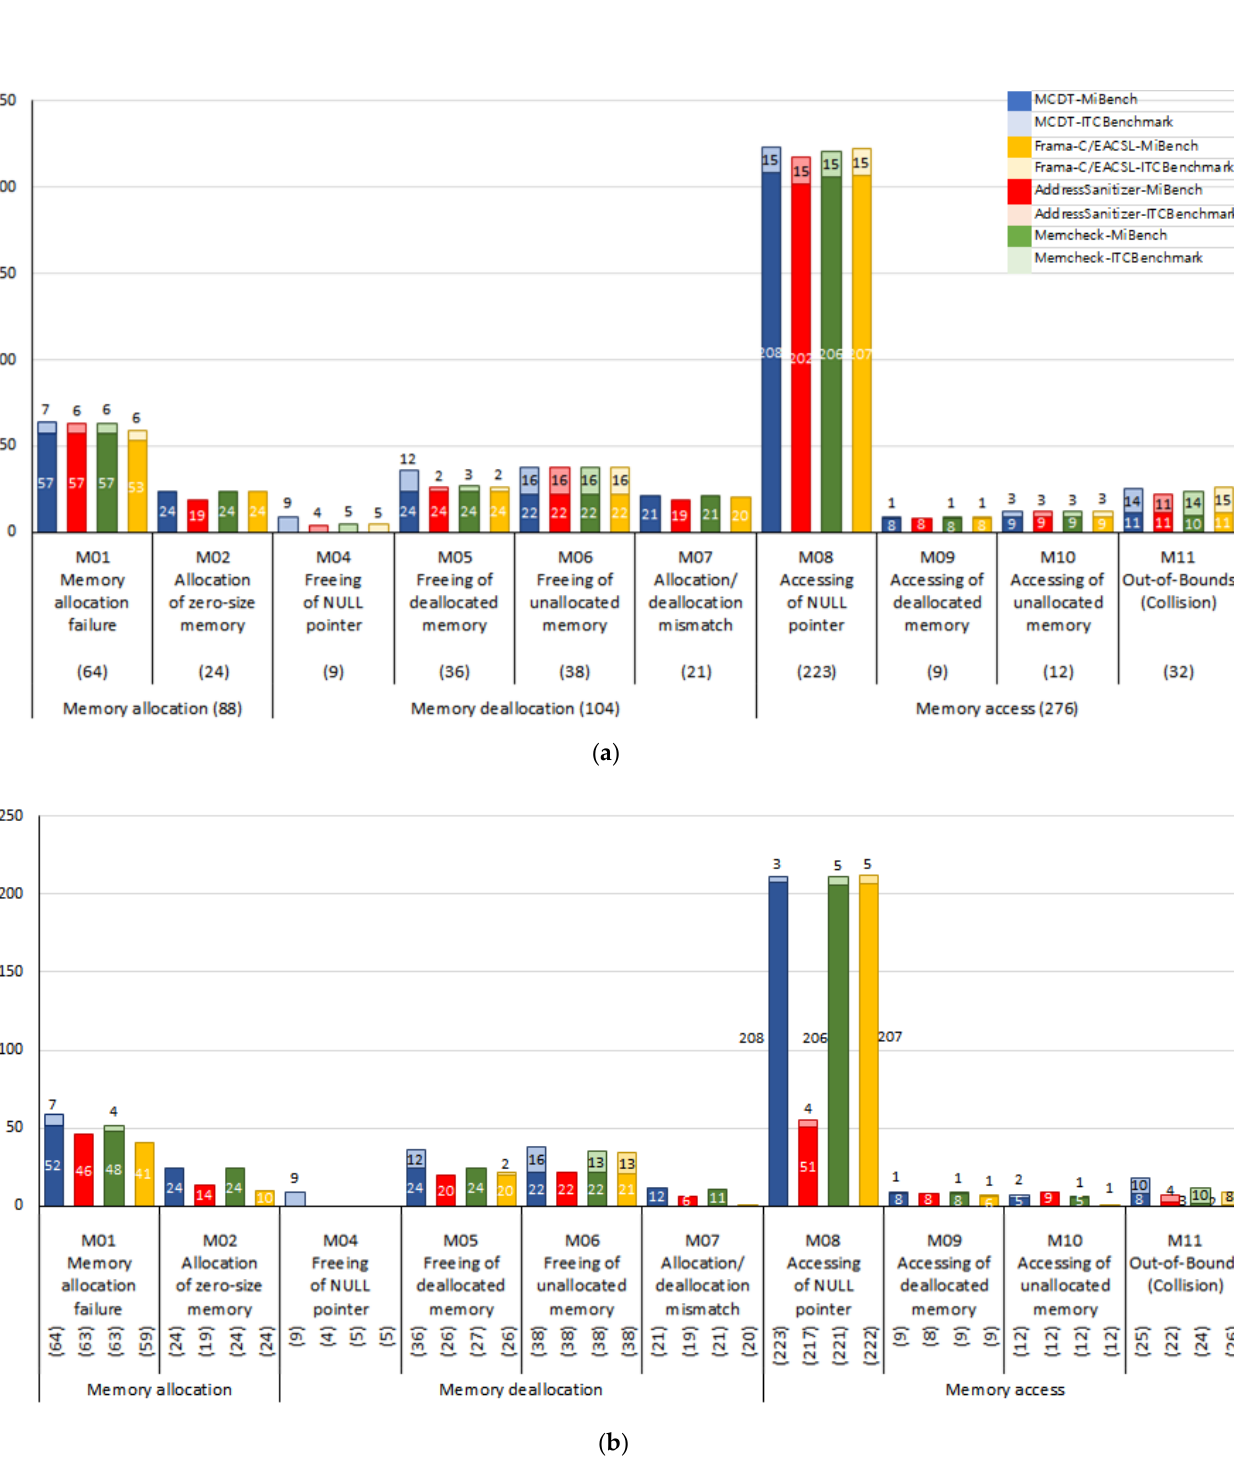
Figure 14. Effectiveness of detecting memory defects when a crash occurred; ( a ) defect-detection rate; ( b ) defect-cause accuracy.